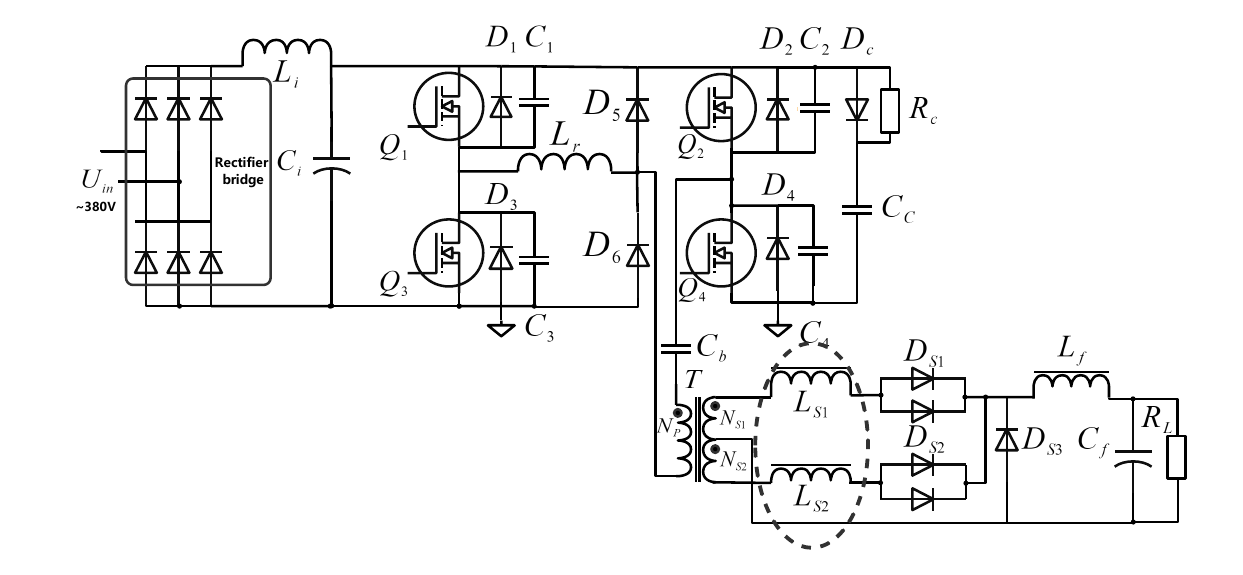
Figure 6. Main circuit structure of ZVS-HBPS-LVHC-SI.